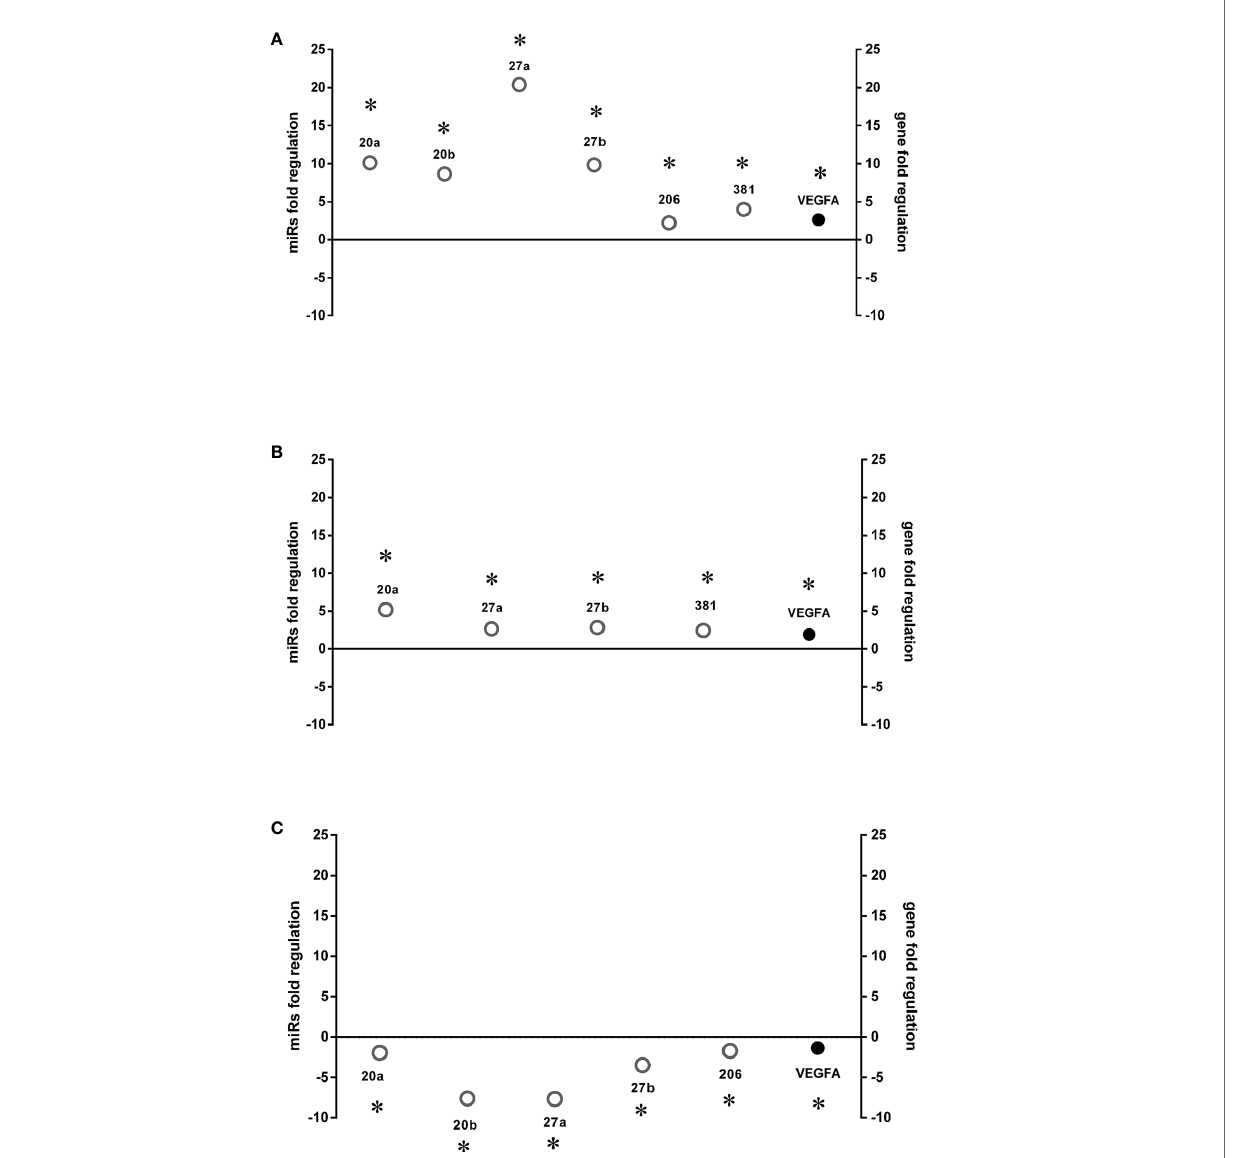
FIGURE 3 | HIF-1 a stabilization induced microRNAs (miRNAs) and correlation with vascular endothelial growth factor (VEGFA) expression. Correlation of microRNAs and VEGFA expression (Fold regulation). (A) *p < 0.05 2 h CoCl 2 treatment vs. control; (B) *p < 0.05 8 h CoCl 2 vs. control (ctrl); (C) *p < 0.05 8h vs. 2h CoCl 2 treatment;